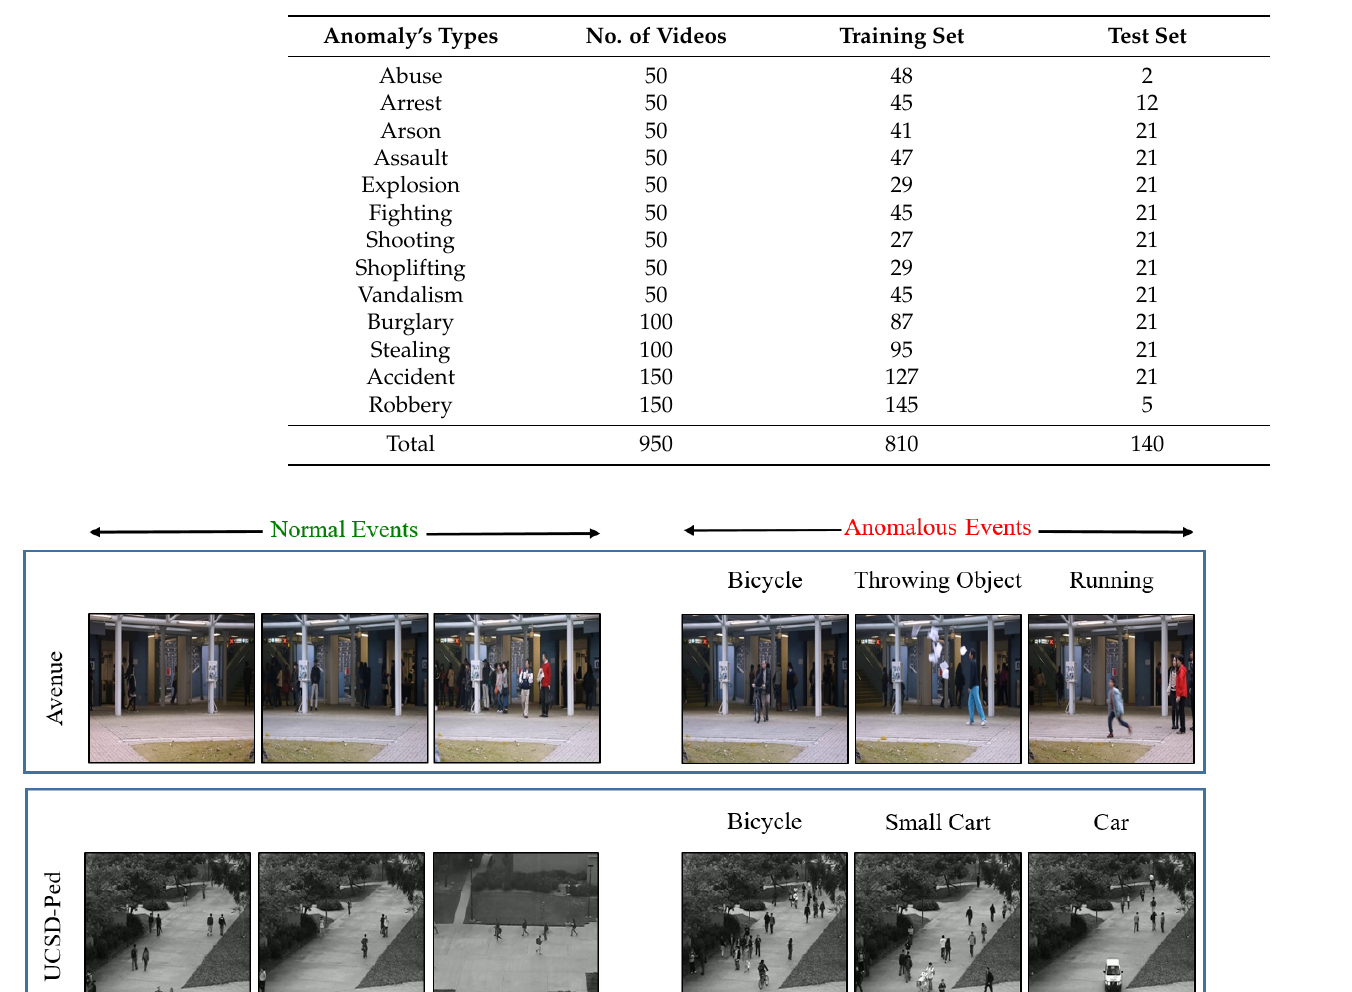
Table 4. The UCF-Crime dataset’s statistical information.